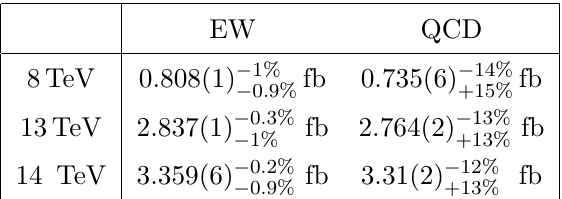
Table 2 . Cross section of the EW and QCD production process at di(cid:11)erent center-of-mass